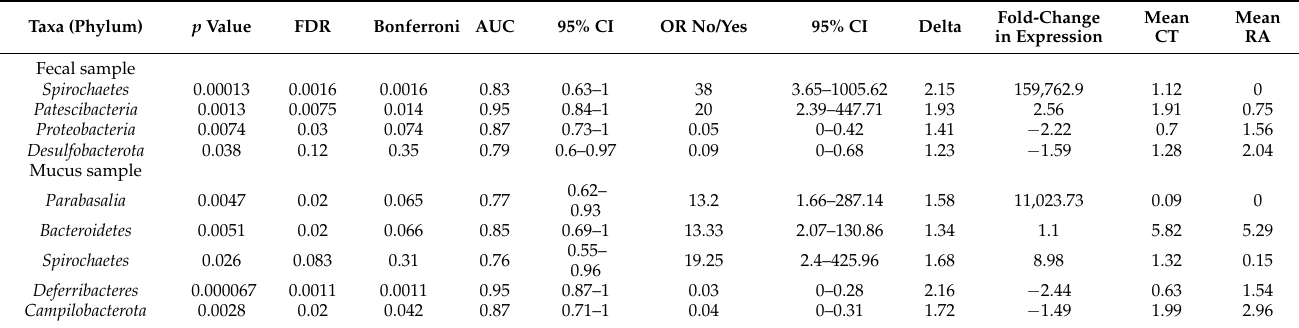
Table 2. Differentially enriched taxa in mice with rheumatoid arthritis and healthy